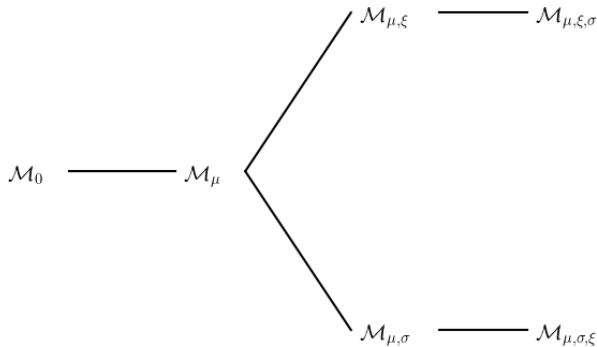
Figure 2. Tree representing the likelihood ratio test (LRT) per- formed in Sect. 3.3. The variable M 0 is the GEV model with sta- tionary parameters, and the variable M µ is the model where µ is nonstationary, etc. Each edge of the tree indicates a likelihood ratio test of the new model on the right of the edge, compared to the old model on the left of the